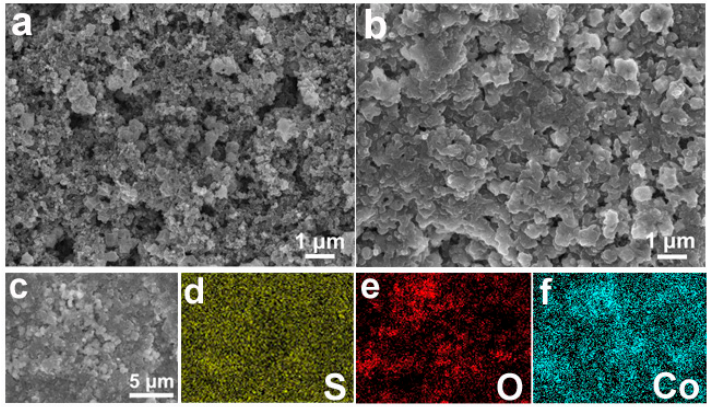
Figure 7. Typical SEM images of the Co 3 O 4 -350 / PI / LLZO separator before cycling ( a ) and after cycling ( b ); the corresponding EDS-mapping images of the cycled Co 3 O 4 -350 / PI / LLZO separator ( c : SEM image; d : element S; e : element O; f : element Co).